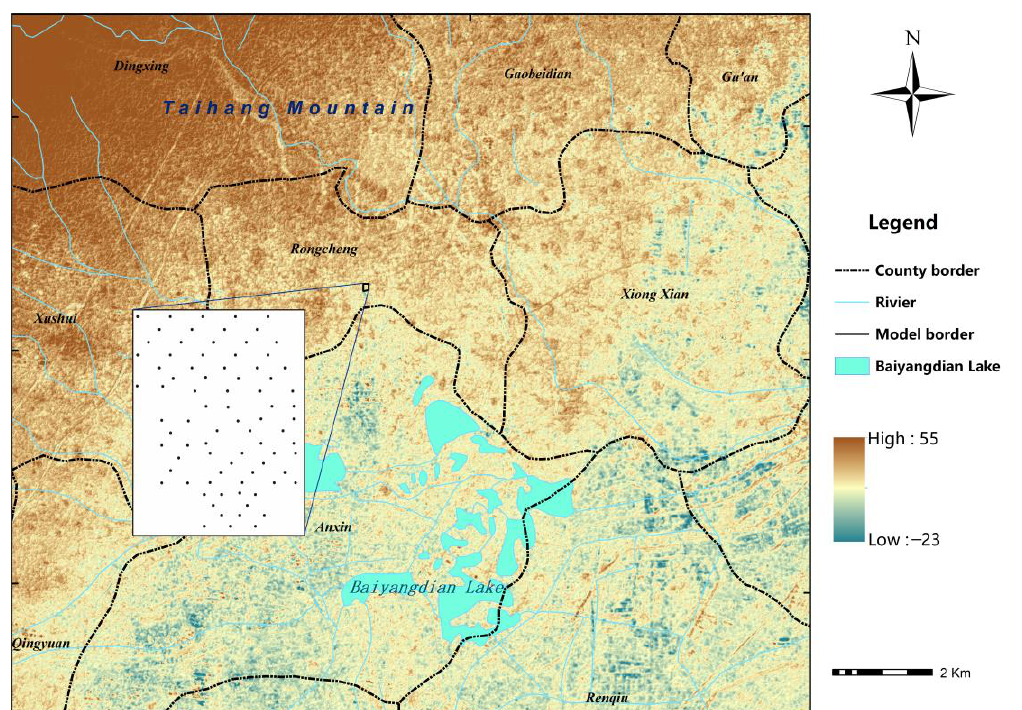
Figure 6. Topography, geomorphology, and distribution of drilling points in the study area.